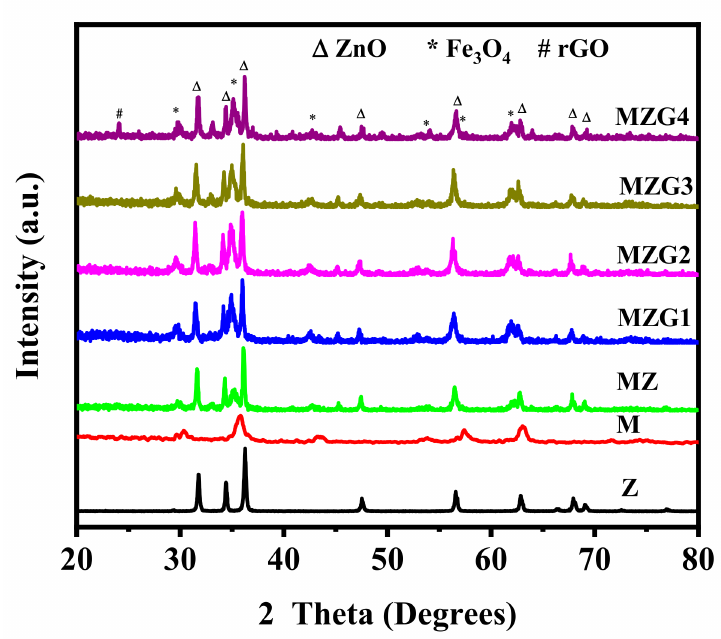
Figure 1. XRD spectra of Z, M, MZ, MZG1, MZG2, MZG3, and MZG4 nanoparticles